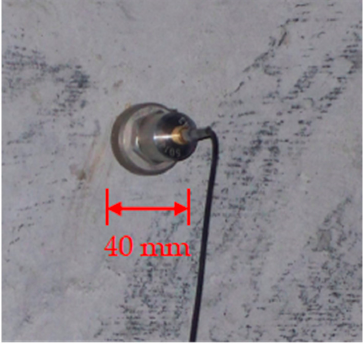
Figure 6. Actual layout of the acceleration sensor [34].